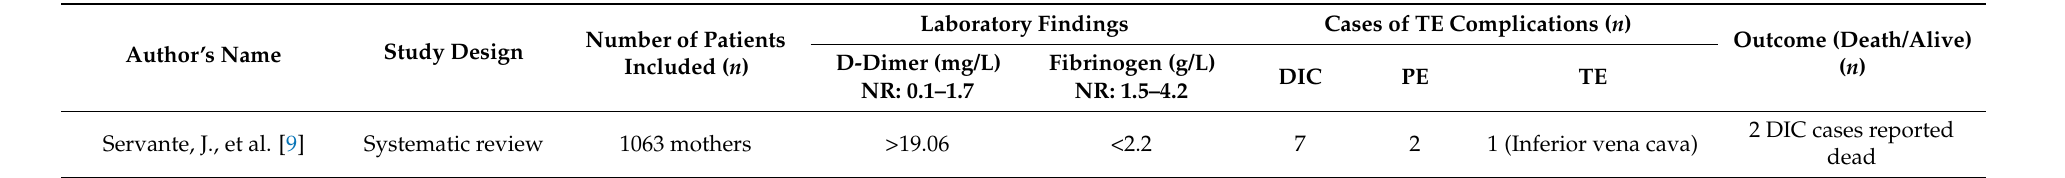
Table 5. Systematic review reporting thromboembolic (TE) complications among pregnant women infected with